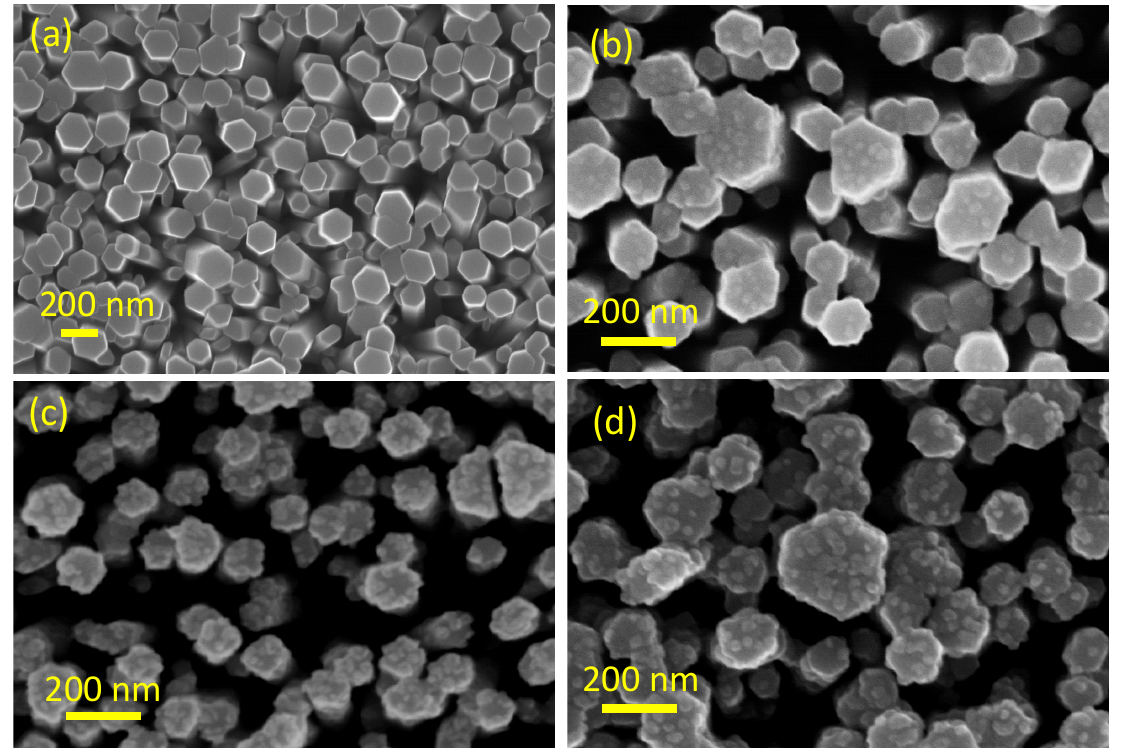
Figure 1. SEM images of ( a ) bare ZnO NWs. ( b – d ) denote ZnO/MoS 2 heterostructures with Mo nominal thickness of 1.5, 5 and 10 nm, respectively.